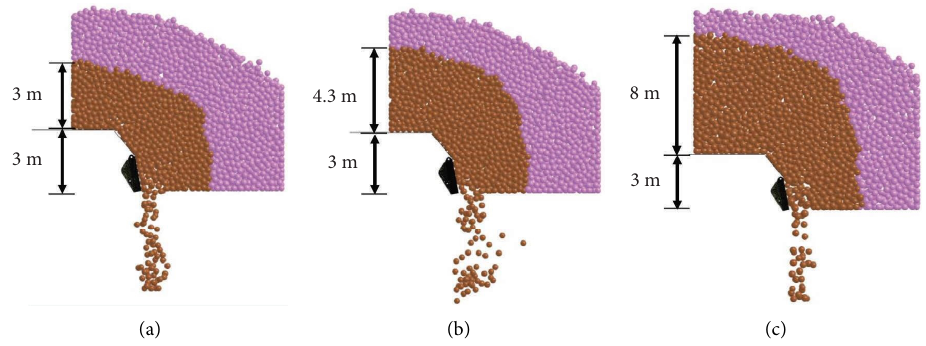
Figure 21: Numerical models of three diferent mining and caving ratios.